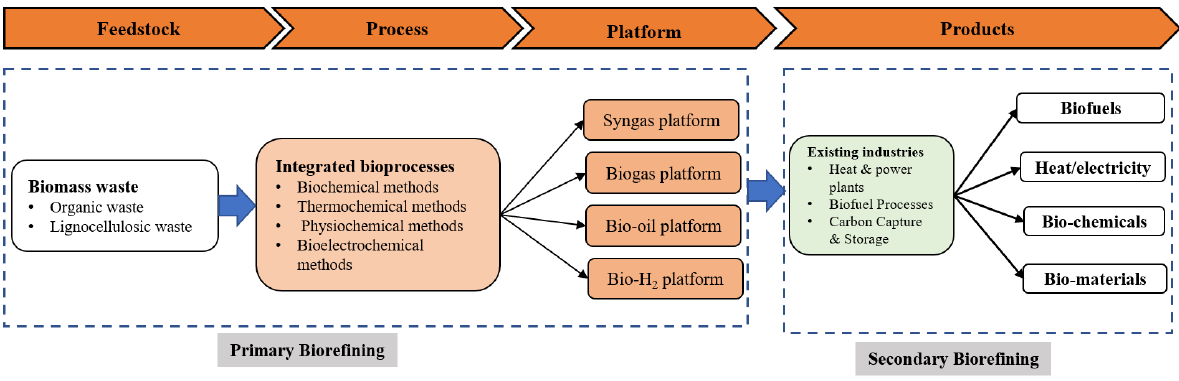
Figure 6. Schematic representation of an integrated waste biorefinery.